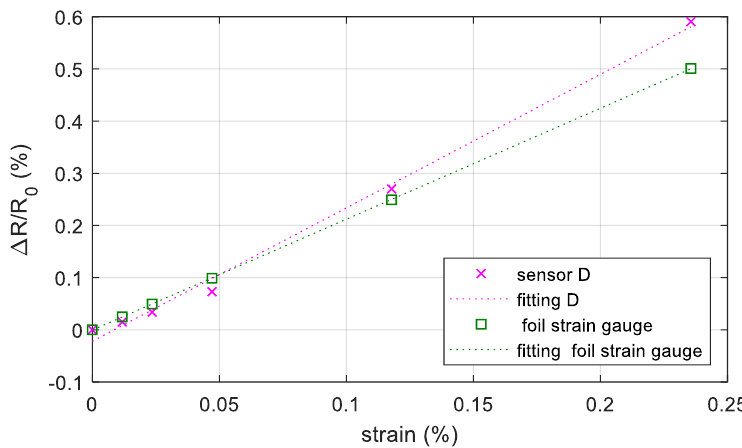
Figure 10. Resistance change with respect to the starting resistance (no external loads) versus the measured strain in the area including the sensor for the printed sensor and for the commercial sensor. The points are the measurements data while the dotted line is the best-fit line using the LLS method.